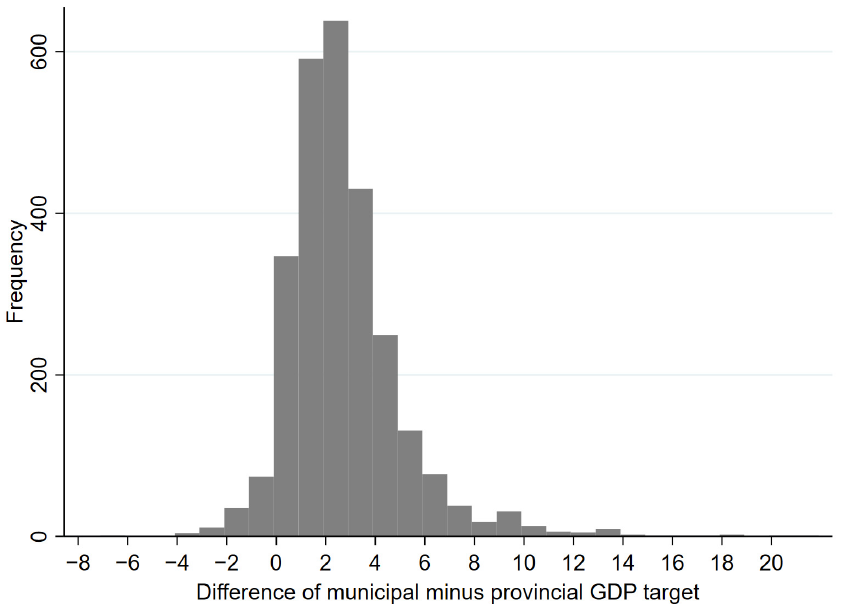
Figure 1. The distribution of the difference between the municipal and provincial GDP targets.